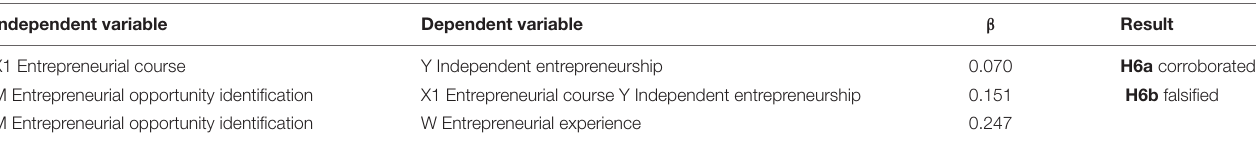
TABLE 9 | Parameters for moderated mediating effect